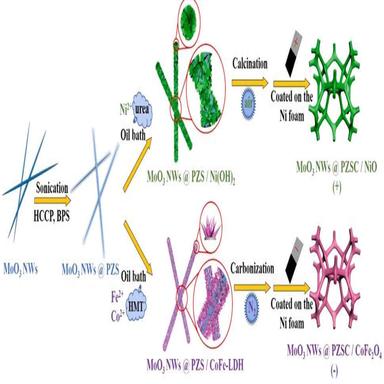
SEM of (a) MoO3, (b) MoO3 @ PZS and (c) MoO3 @ PZSC. (d) TEM of MoO3 @ PZS. (e) XRD of MoO3 @ PZSC, MoO3 @ PZS and MoO3. (f) Raman spectra of MoO3 @ PZSC, MoO3 @ PZS and MoO3.